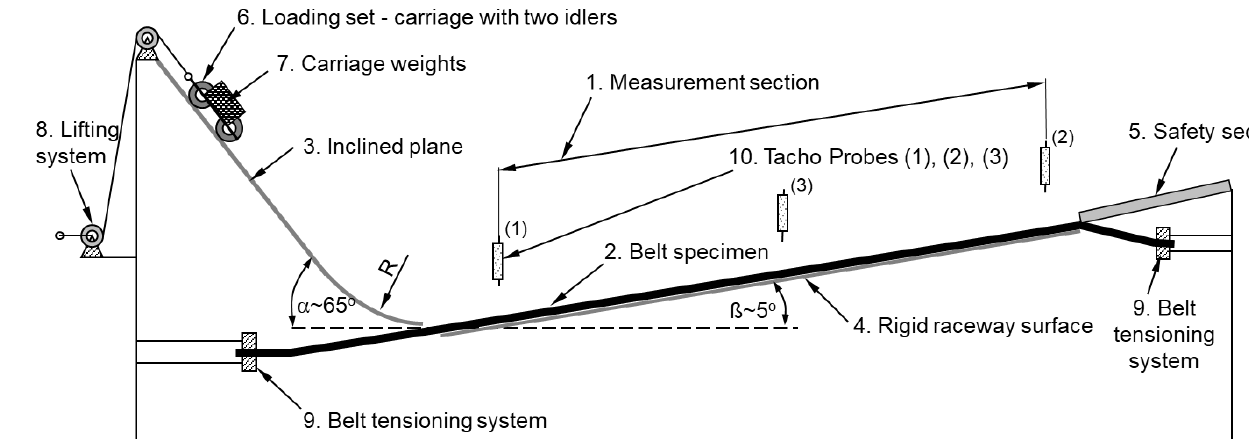
Figure 2. Schematic representation of the test rig for measuring belt indentation rolling resistances. The symbols shown in Figure 2 are as follows: